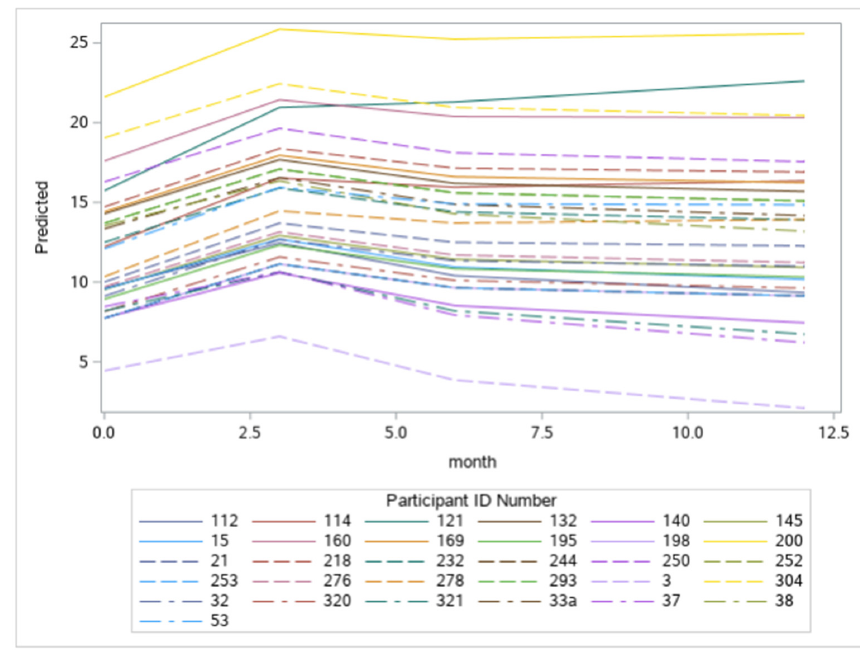
Figure 3. Examples of predicted individual growth curves as a function of months.